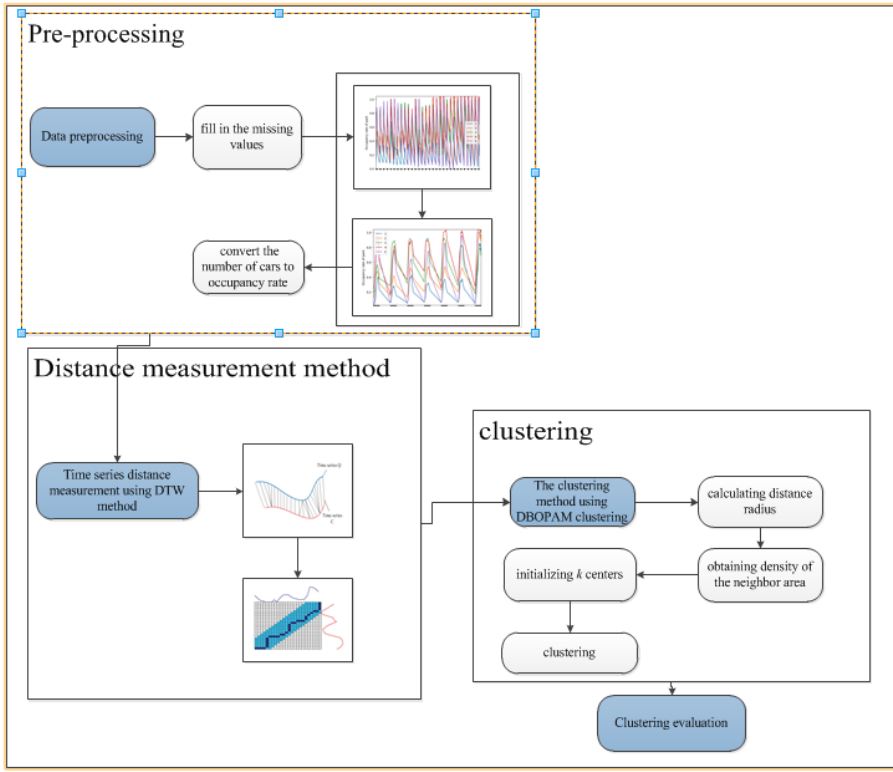
Figure 2. Framework of car park clustering.